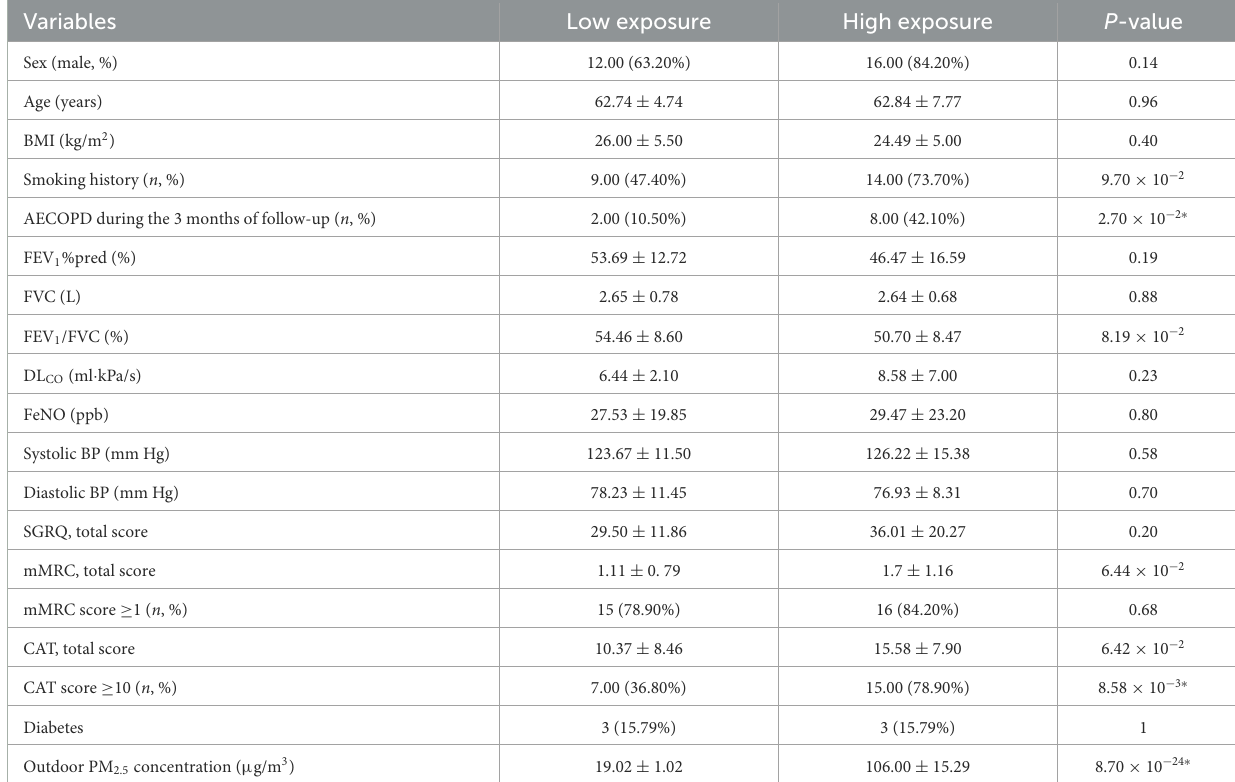
TABLE 1 Characteristics of the study participants.